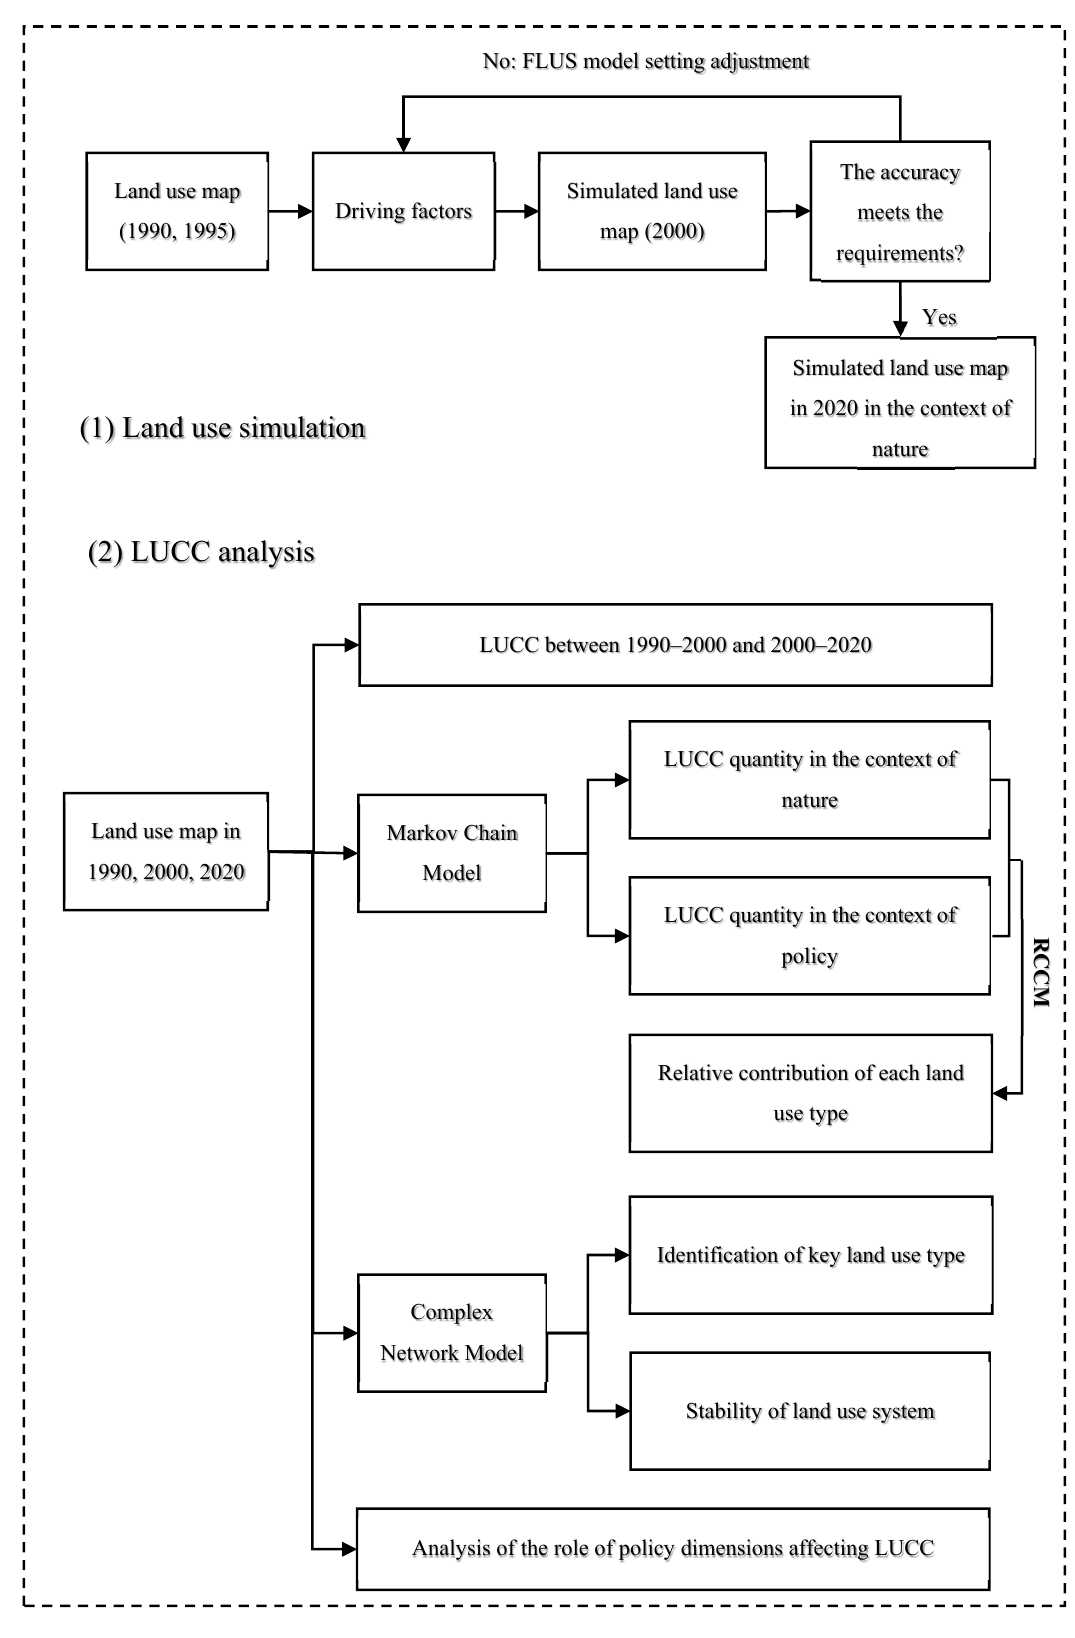
Figure 3. Flowchart of the research methods.